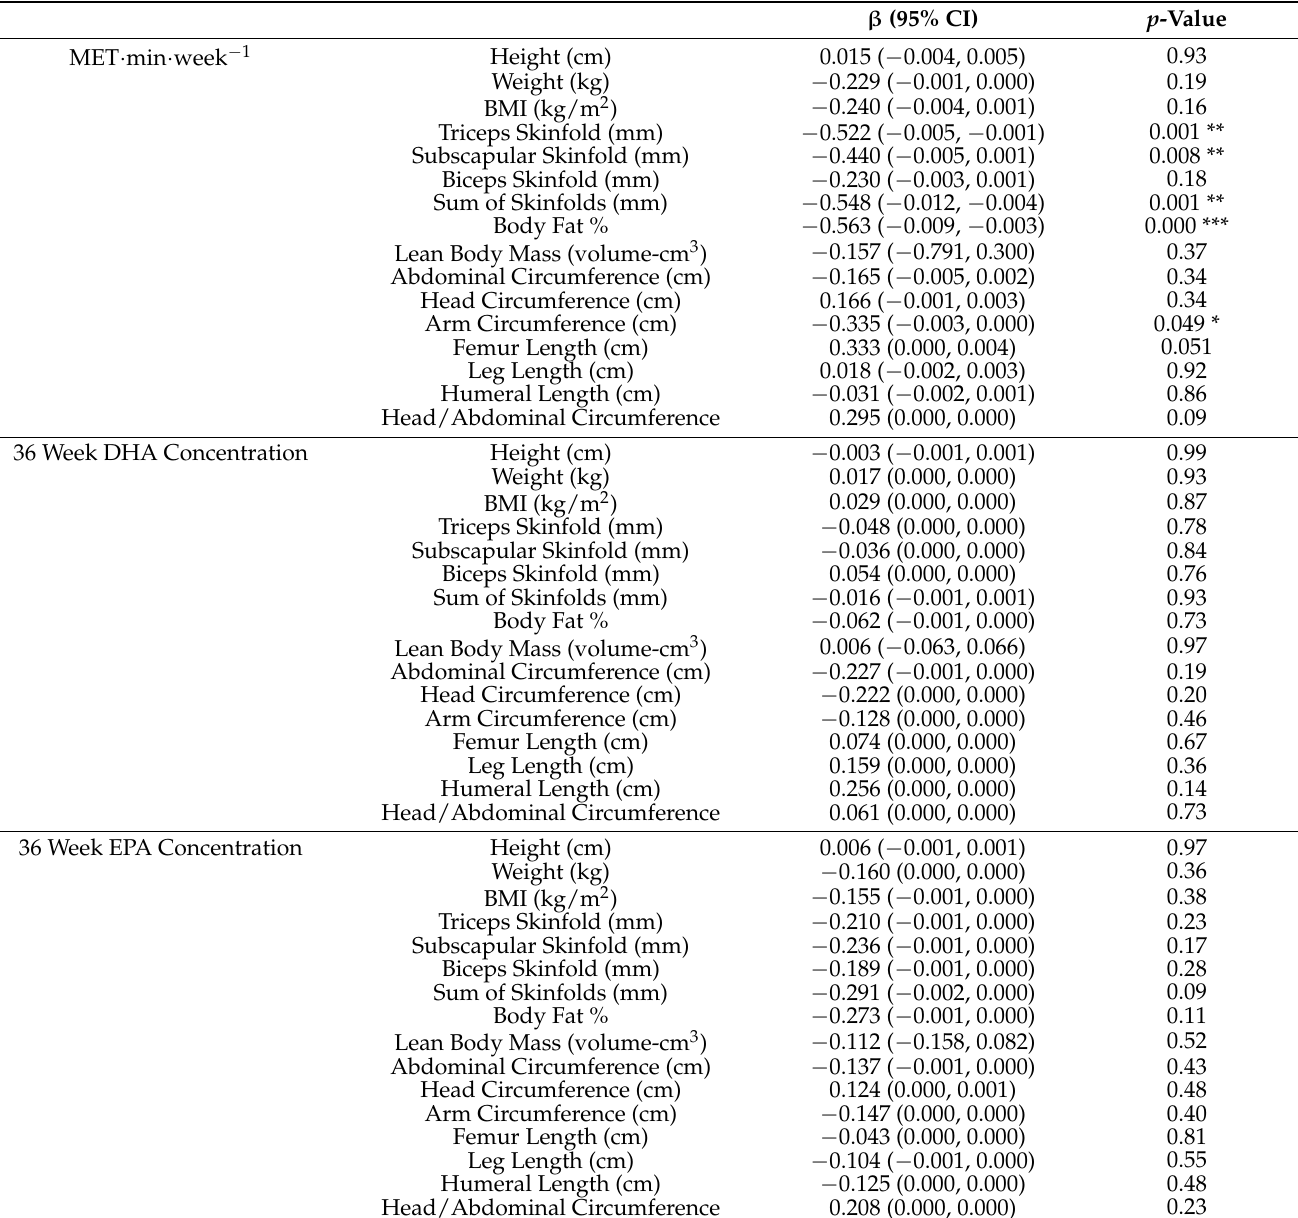
Table 4. Multiple linear regression models of maternal exercise dose, DHA, and EPA concentrations influence on infant body composition measures at 1 month of